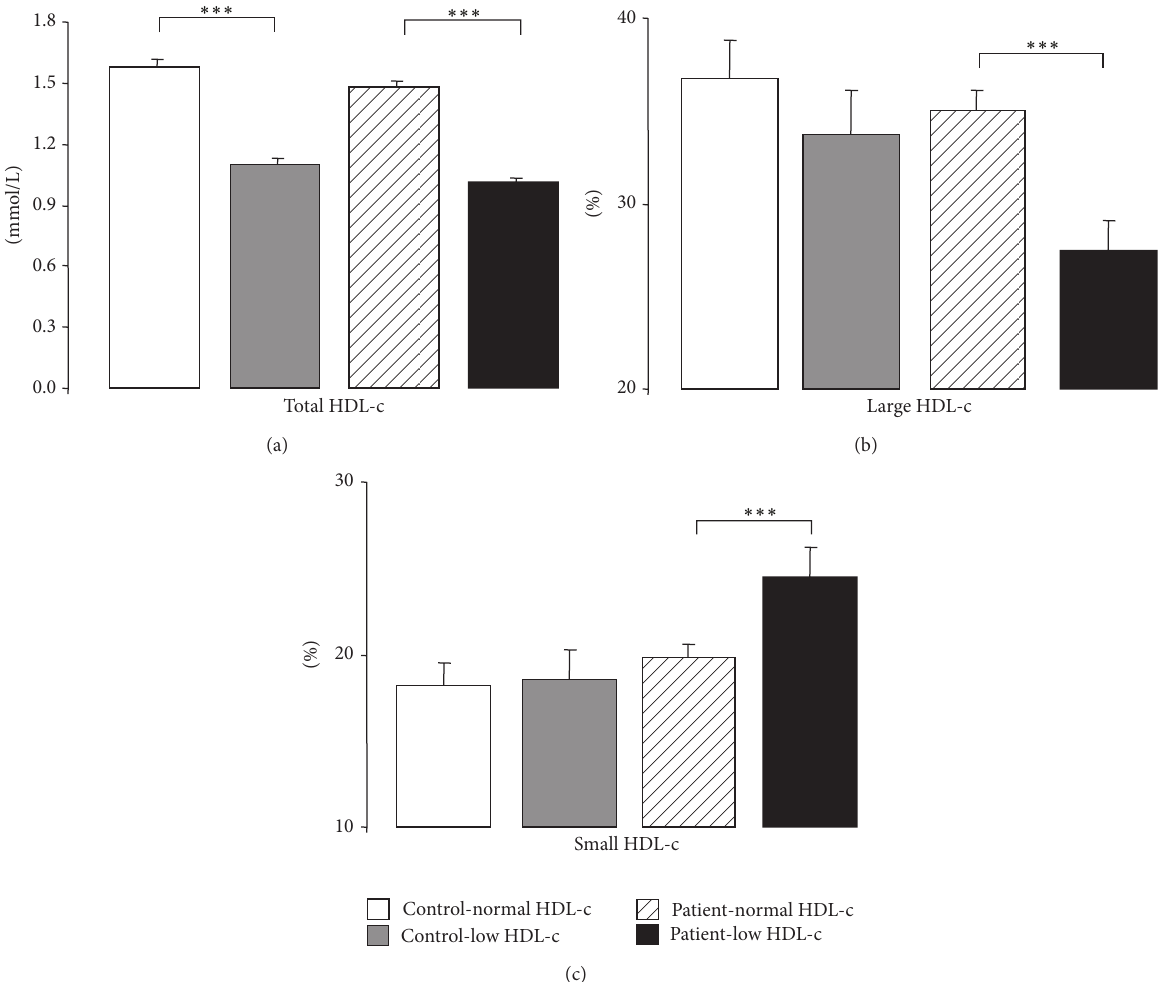
Figure 1: Serum total-HDL-c (a), large HDL-c (b), and small HDL-c (c), in the study groups. Results are presented as mean ± SEM. ∗∗∗ 𝑃 < 0.001